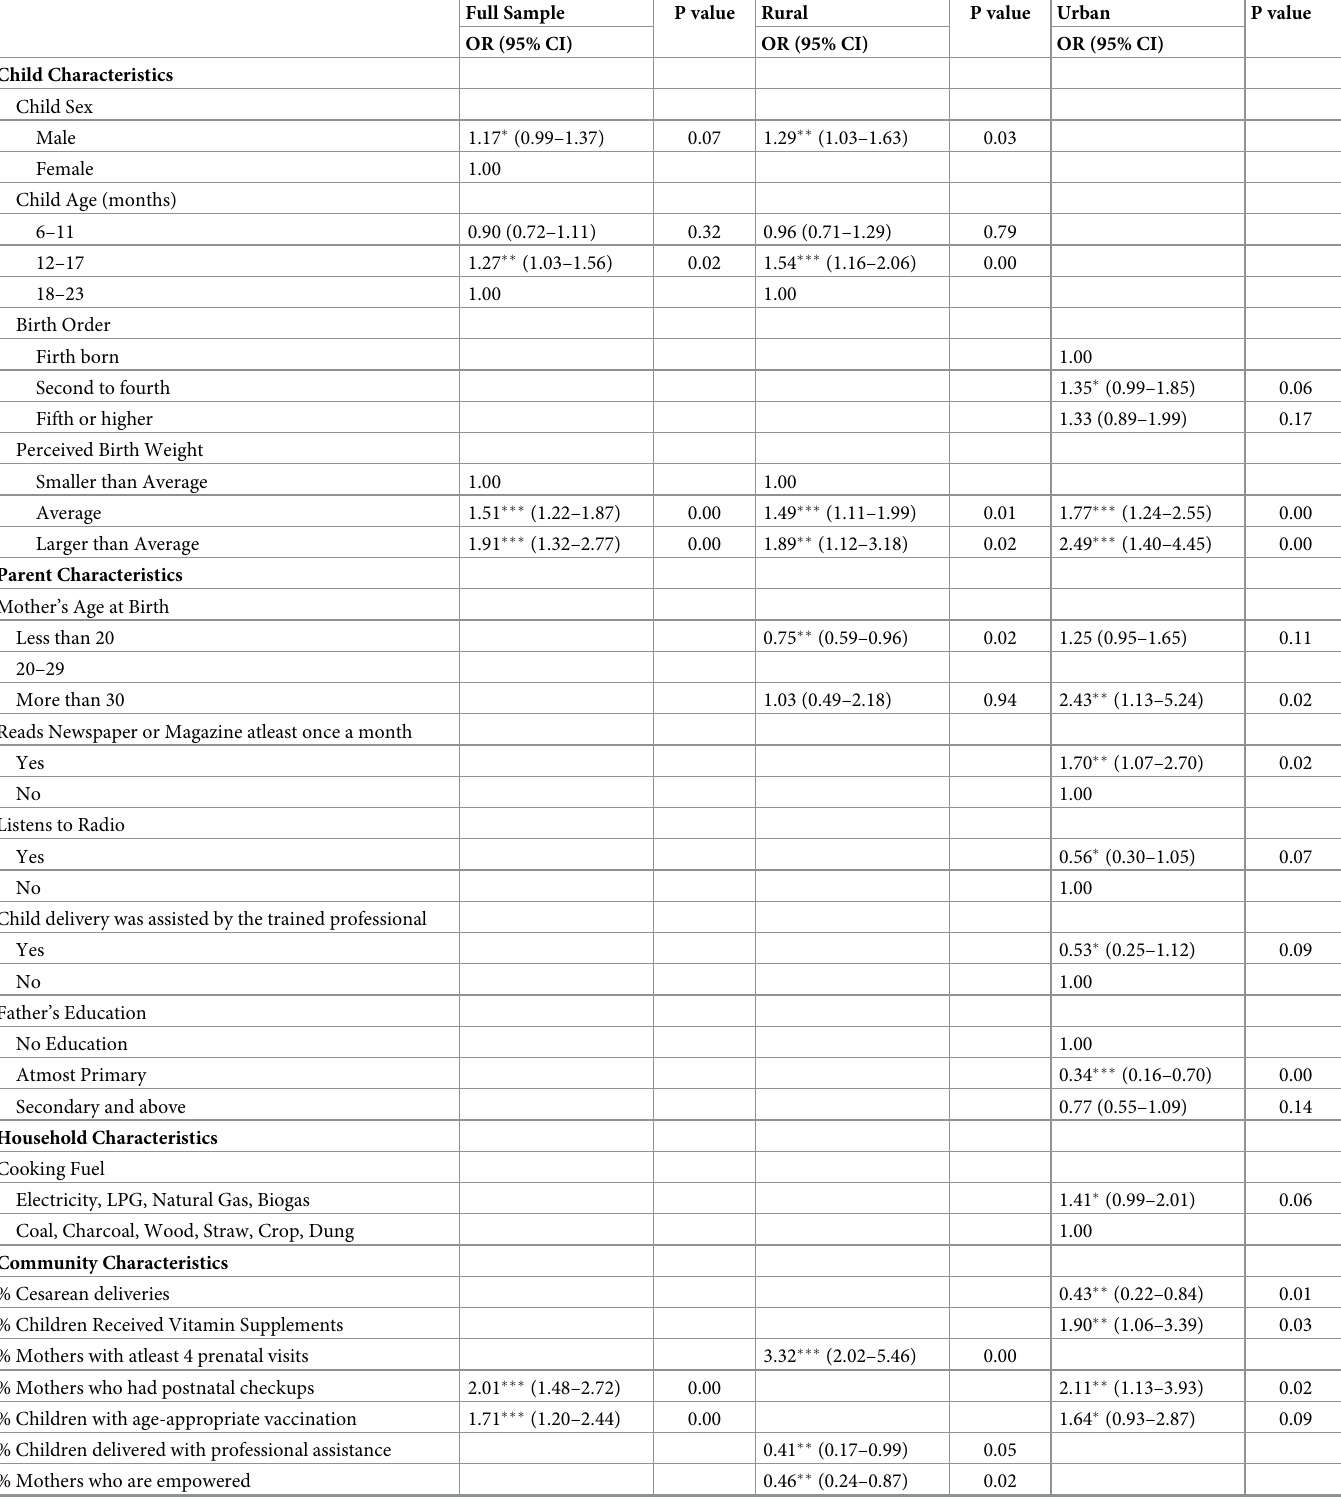
Table 4. Significant correlates (OR (95% CI)) of adequate meal frequency as per WHO recommendations using multivariate logistic